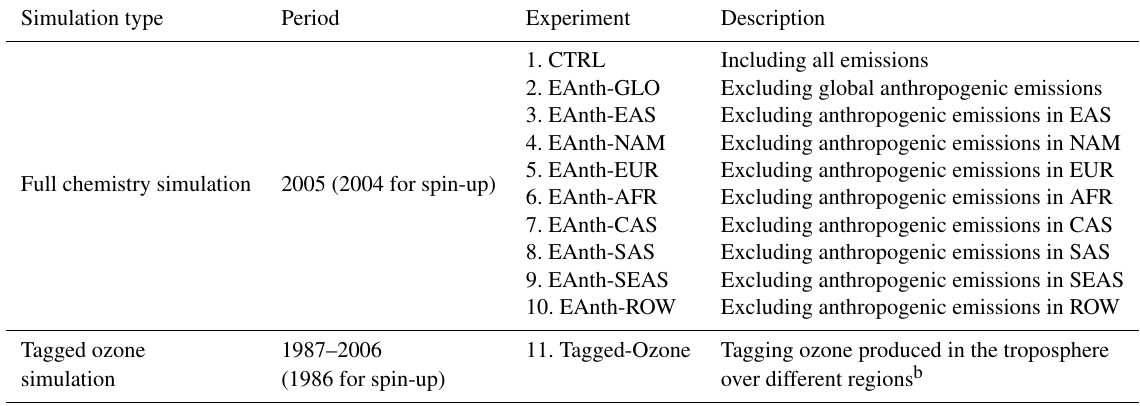
Table 1. GEOS-Chem simulations and experiments in this study.